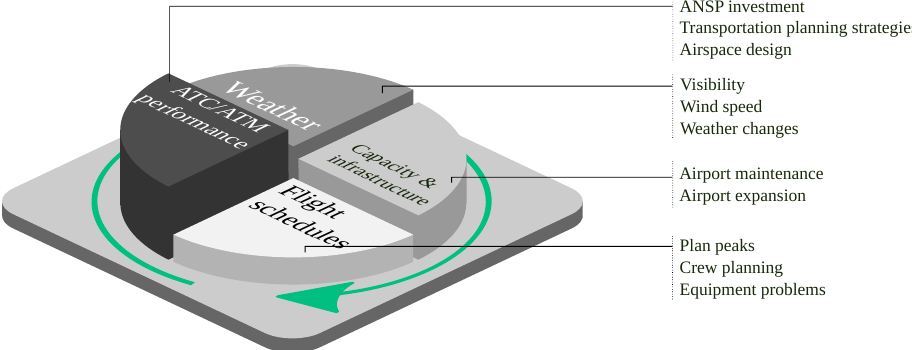
Figure 2. Interactions of PI related to flight efficiency and delay (cf. CANSO, [28], p.